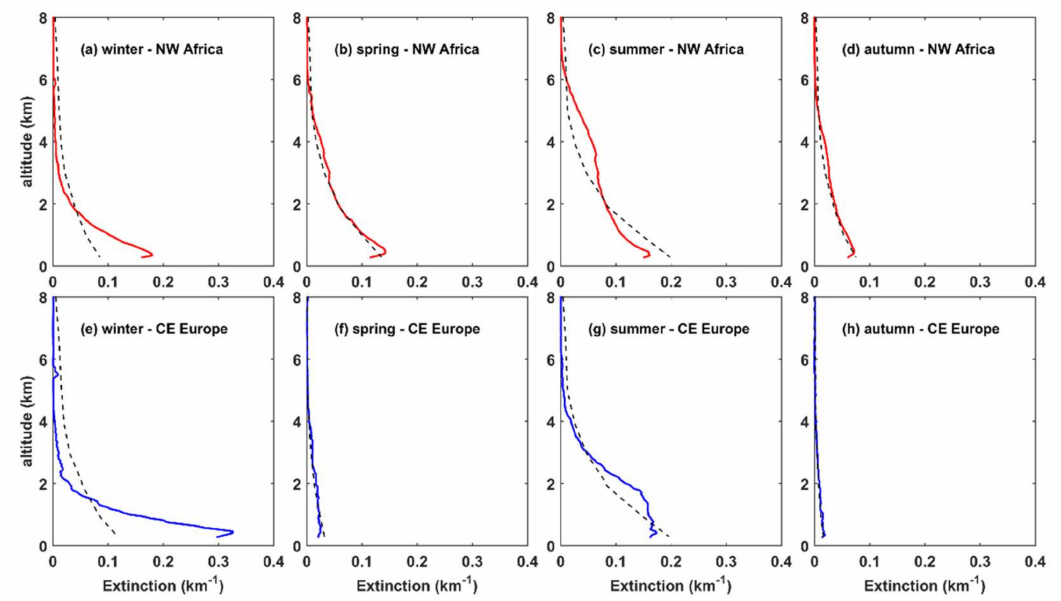
Figure A11. LIVAS (red line for NW Africa, blue line for CE Europe) and libRadtran (black dashed line) default extinction coefficient profiles for AOD at 350 nm. The results are shown for the four seasons of the